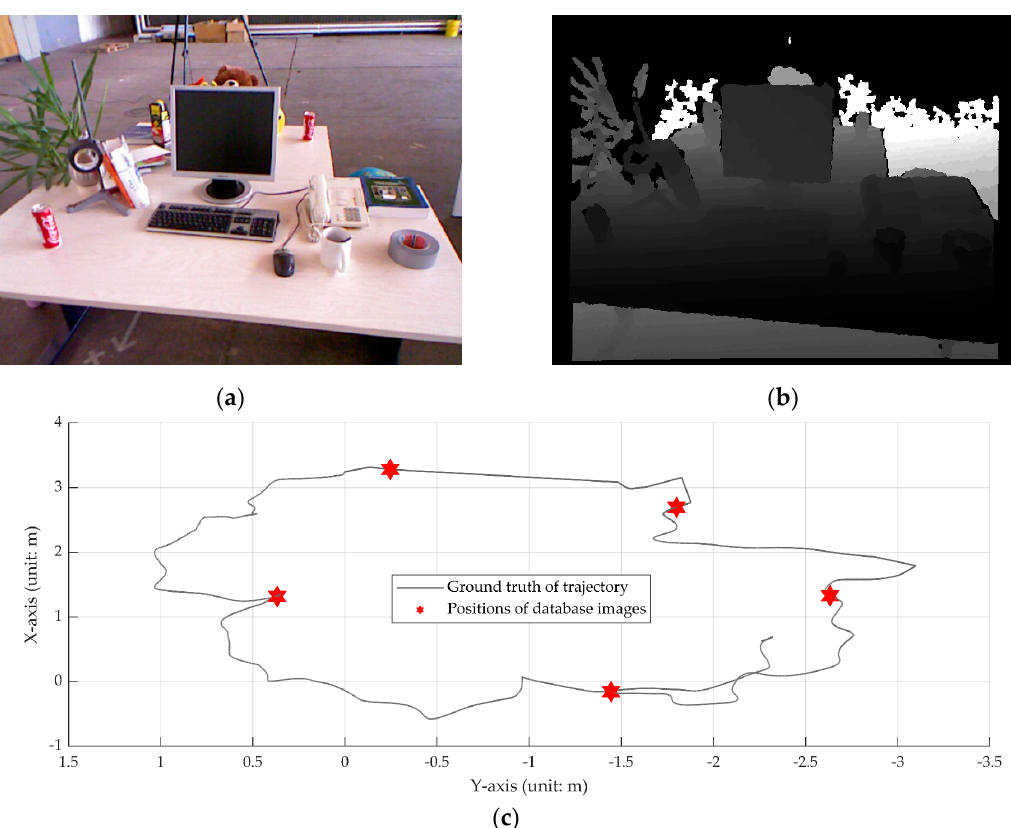
Figure 1. An example of RGB-D image and the positions of database images. ( a ) RGB image; ( b ) corresponding depth image of this RGB image; ( c ) positions of database images (shown by red hexagon) and ground truth of trajectory (shown by gray line).